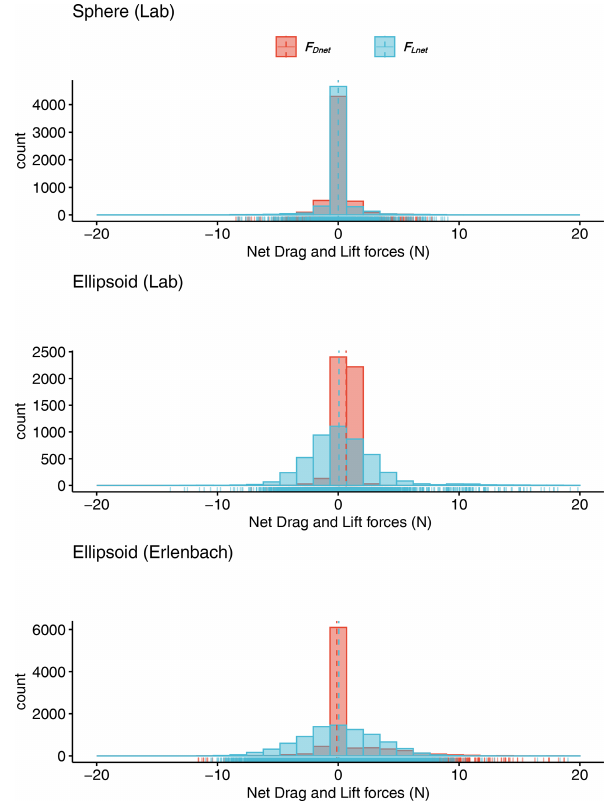
Figure E1. Histogram of inertial forces from all experiments. The inertial dynamics show that net lift ( F Lnet ) and drag ( F Dnet ) forces consistently fluctuate around 0. The vertical lines indicate the corresponding medians. The mean force magnitude for the sphere (in the lab) is F Dnet = 0 . 57N and F Lnet = 0 . 62N for the drag and lift directions, respectively. For the ellipsoid in the laboratory experiment the mean drag force magnitude is F Dnet = 0 . 74N and the mean lift force magnitude is F Lnet = 2 . 13N. Finally for the ellipsoid in Erlenbach mean F Dnet = 1 . 22N and F Lnet = 2 .